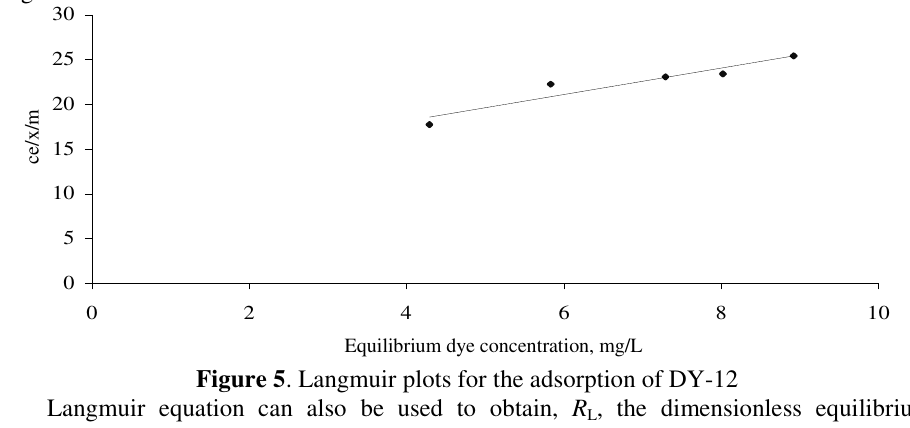
Figure 5 . Langmuir plots for the adsorption of DY-12